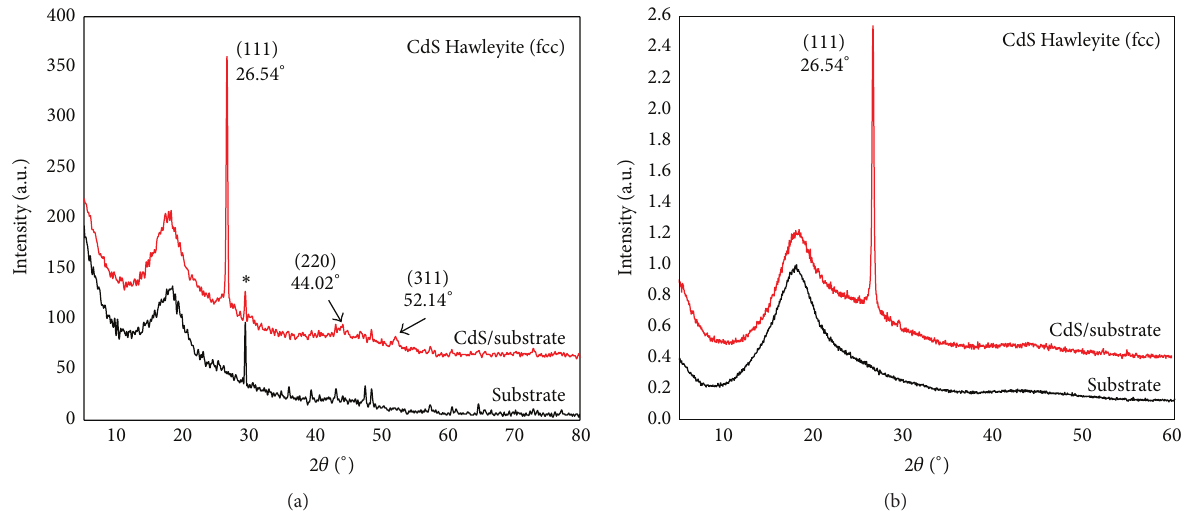
Figure 6: XRD profiles of CdS films deposited onto MWCNT/PSF composite substrates by two different configurations: (a) grazing incident angle configuration and (b) Bragg-Brentano configuration. The XRD profile of the composite substrate solely (without CdS film) is also presented on each